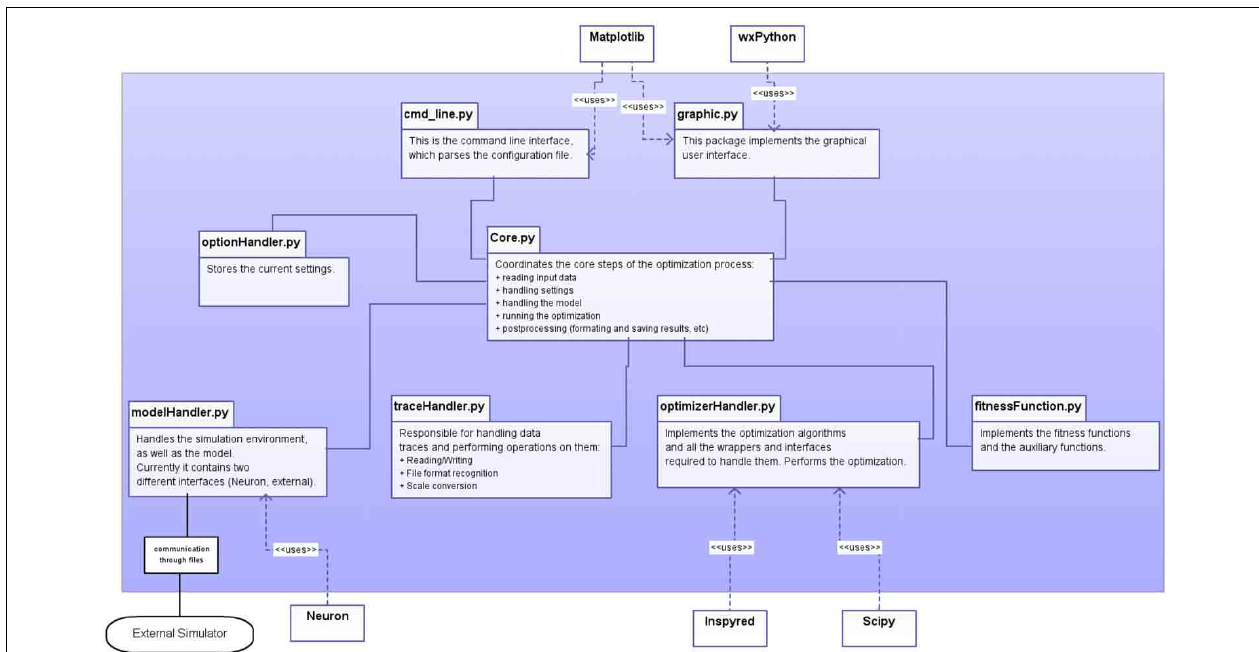
FIGURE 1 | Schematic representation of the design of the software, showing the main components of Optimizer (within the blue shaded area), interactions among its modules and with critical external